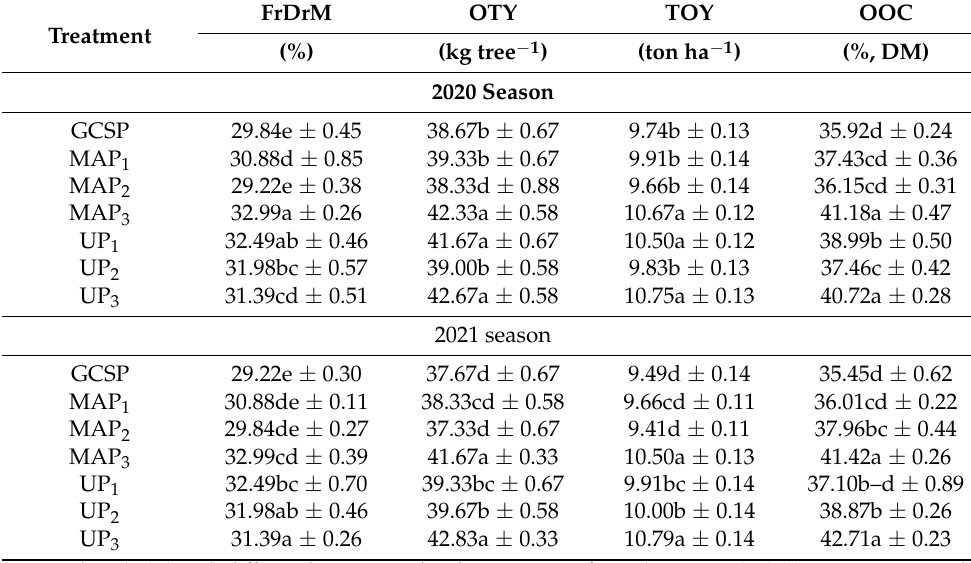
Table 8. Influence of different levels of MAP and UP in comparison with the recommended GCSP level on fresh matter %, total olive yield (both tree and ha), and olive oil content of olive ( Olea europaea L. arbequina cv.) trees grown in sandy loam clay soil under multi-abiotic stresses (CaCO 3 = 8.8 vs.